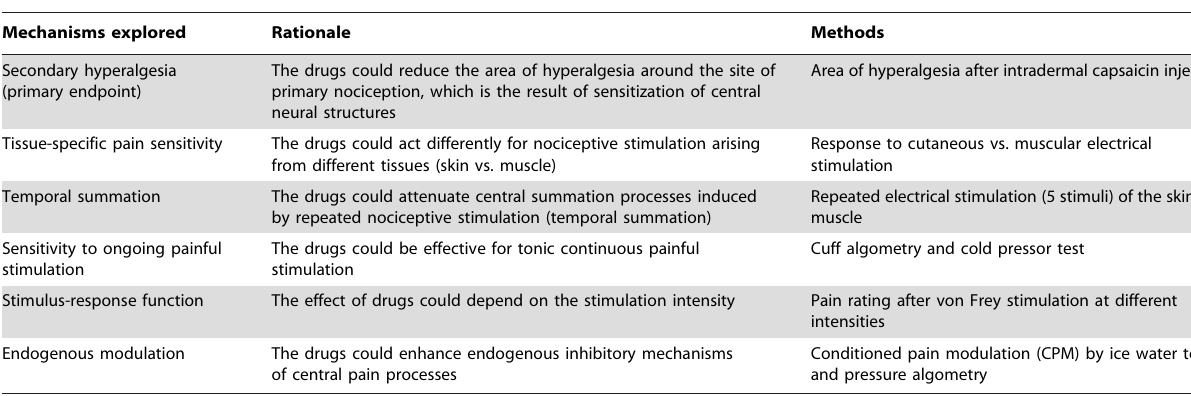
table 1. In particular, we applied models of hyperalgesia, tissue- specific pain sensitivity (cutaneous vs. muscular), sensitivity to short and ongoing painful stimulation, temporal summation (increase in Table 1. Experimental pain tests